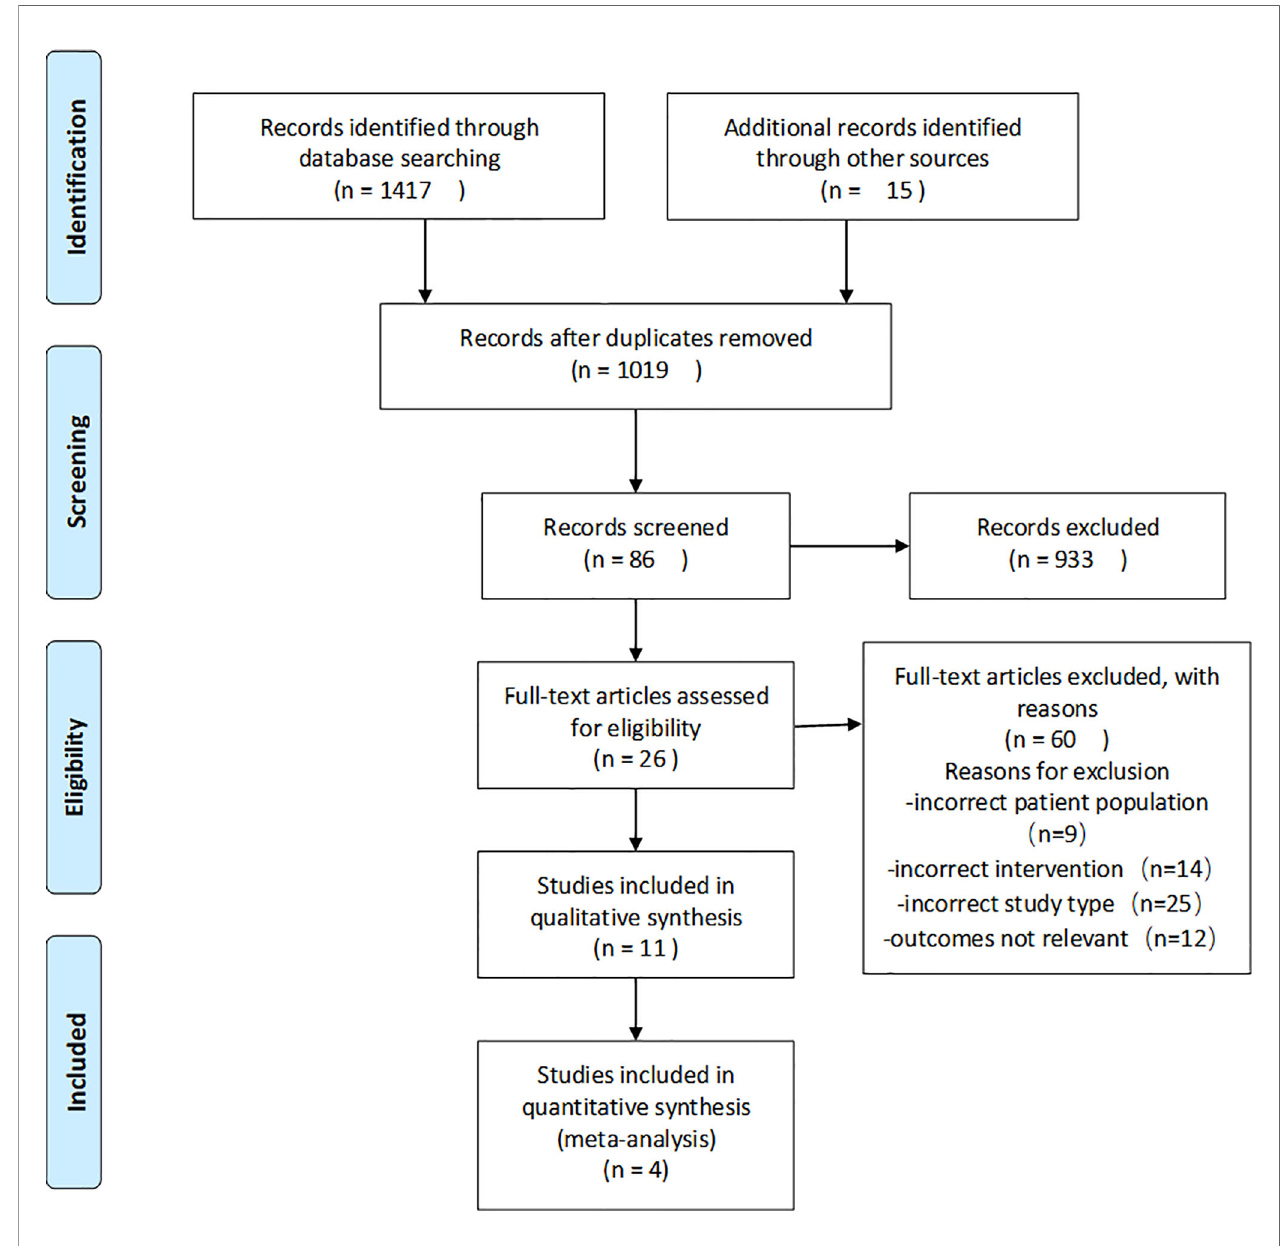
FIGURE 1 | Flowchart for the systematic review process and data acquisition.